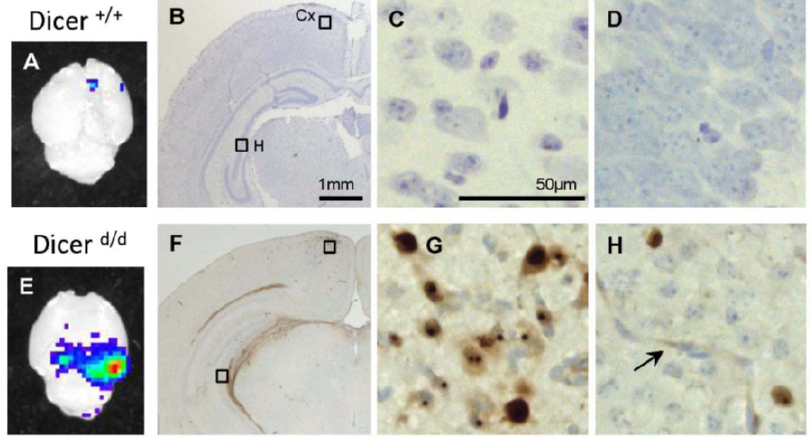
Figure 5. Immunohistochemistry reveal specific localization of MCMV in the brain of infected Dicer d/d neonates. ( A ) and ( E ). Snapshot images showing luminescence emitted by a control (Dicer +/+ ) and a mutant (Dicer d/d ) brains respectively. Examples of immunohistochemical detection of E1 protein in Dicer +/+ ( B – D ) and Dicer d/d brains ( F – H ) include macroscopic images ( B ), ( F ) and magnifications of selected regions of retrosplinal cortex (Cx; ( C ), ( G )) and hippocampus (H; ( D ), ( H )) at Bregma–3.08 mm. Immunolocalization of MCMV using the CROMA 103 primary antibody and peroxidase- labeled secondary antibody was depicted in brown and cresyl violet neuronal detection in blue. Epithelial staining in blood vessels is indicated by the